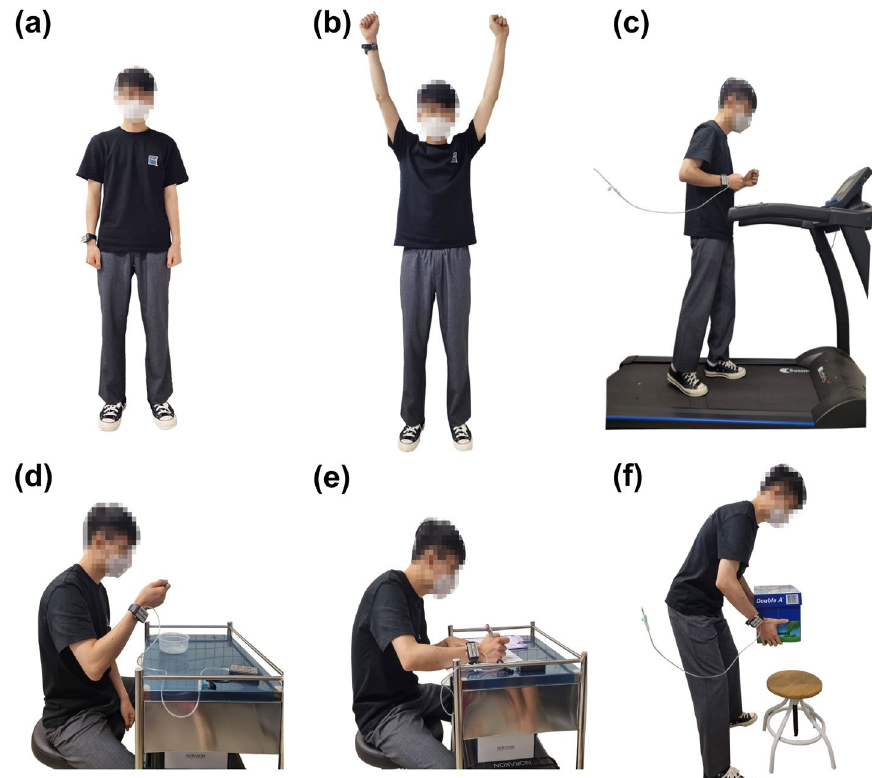
Fig. 3 Daily activities performed: ( a ) standing, ( b ) stretching, ( c ) jogging, ( d ) eating, ( e ) writing and ( f )